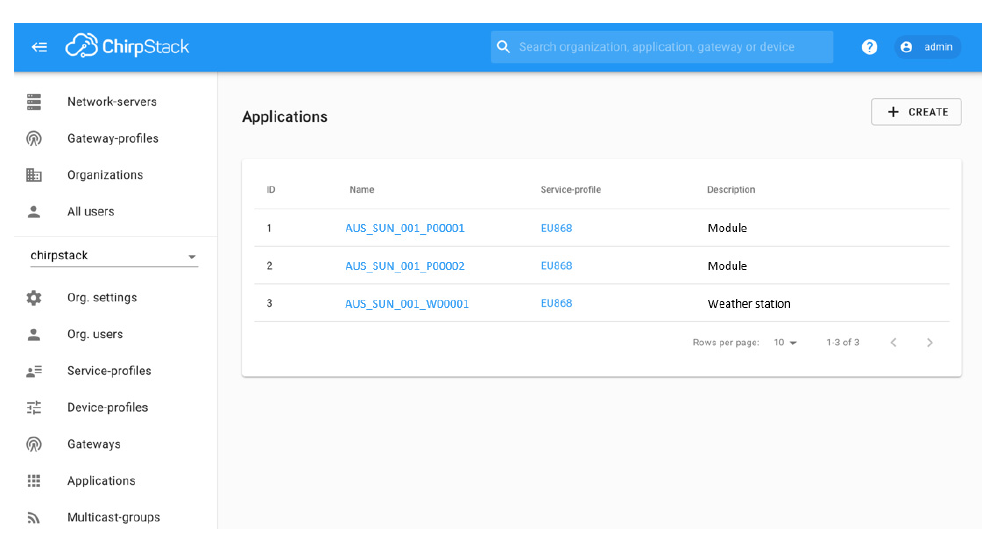
Figure 2. ( a ) ESP+ LoRaWAN edge device ( b ) Raspberry Pi + LoRaWAN Gateway.